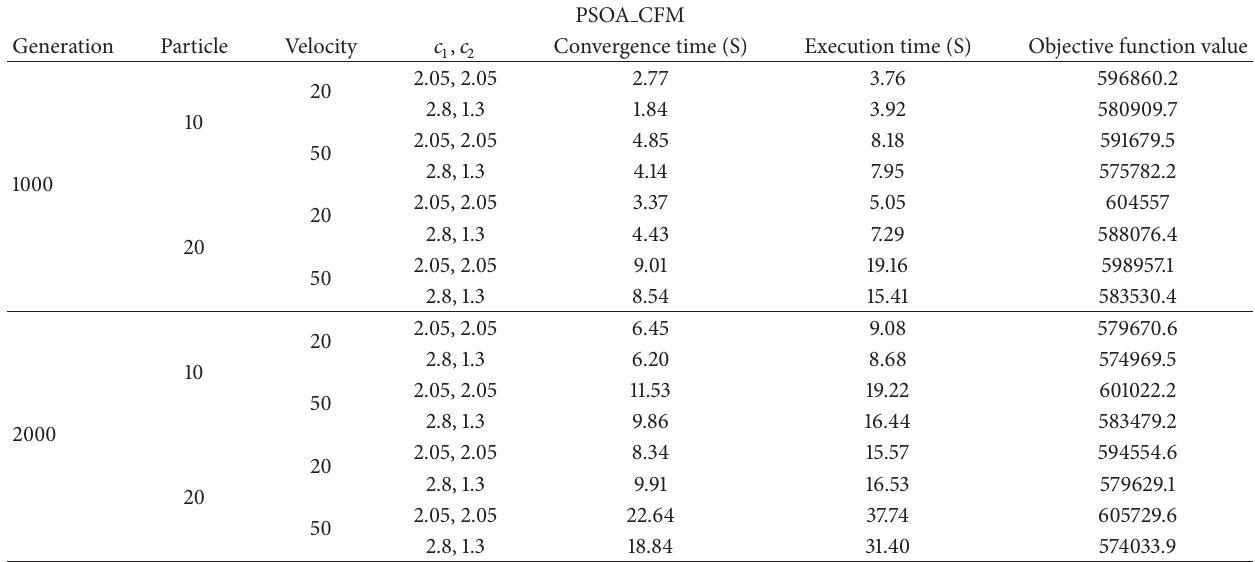
Table 4: Experimental design results of PSOA CFM with different groups of parameters.